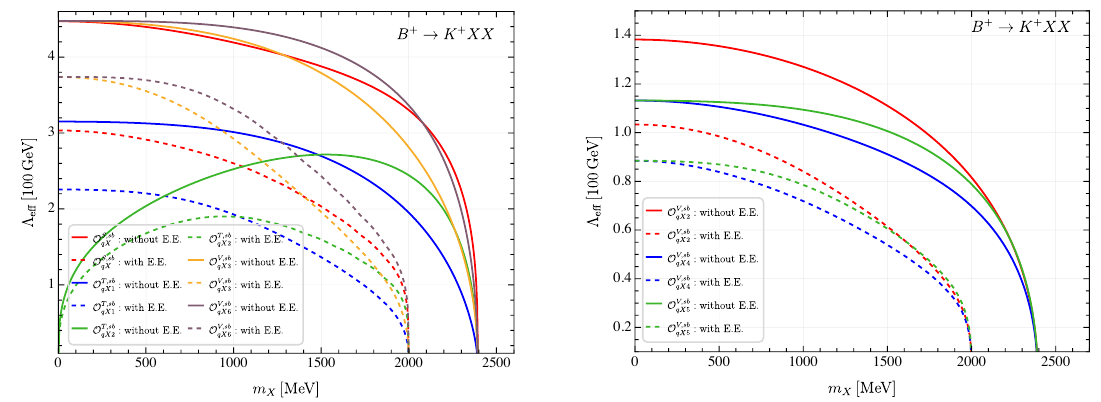
Figure 7 . Constraints on the effective new physics scale as a function of the DM mass m from the inclusive tag Belle II B + → K + ν ¯ ν for the vector DM of scenario